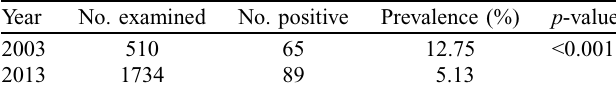
Table 1. Egg positive rate of Enterobius vermicularis in children in studies in 2003 and